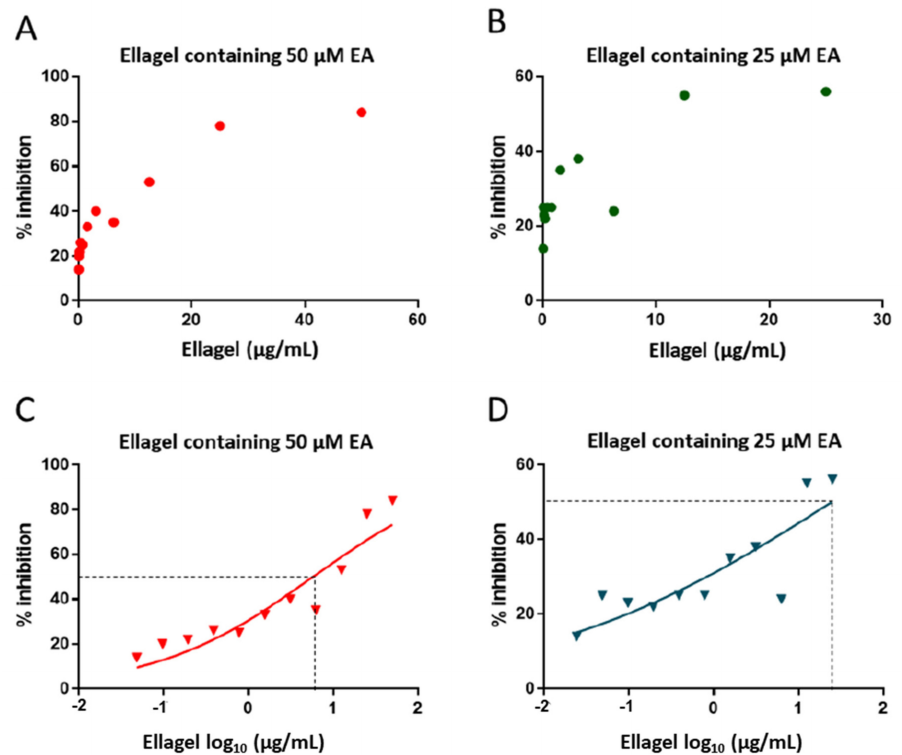
Figure 4. The effects of ellagic acid (EA) on levels of six immune mediators in TZM-bl cell super- natants, measured by Luminex technology at 48 h in cells treated with EA before (Pre-treatment) or after HIV-1 challenge (Post-treatment). The mediators are IL-2 ( A ), IL-4 ( B ), TNF α ( C ), IL-8 ( D ), CCL2 ( E ) and IL-6 ( F ). Bars show the mean concentration ± SD of two independent experiments. The four additional cytokines that were measured concurrently were below the level of detection and are therefore not shown.